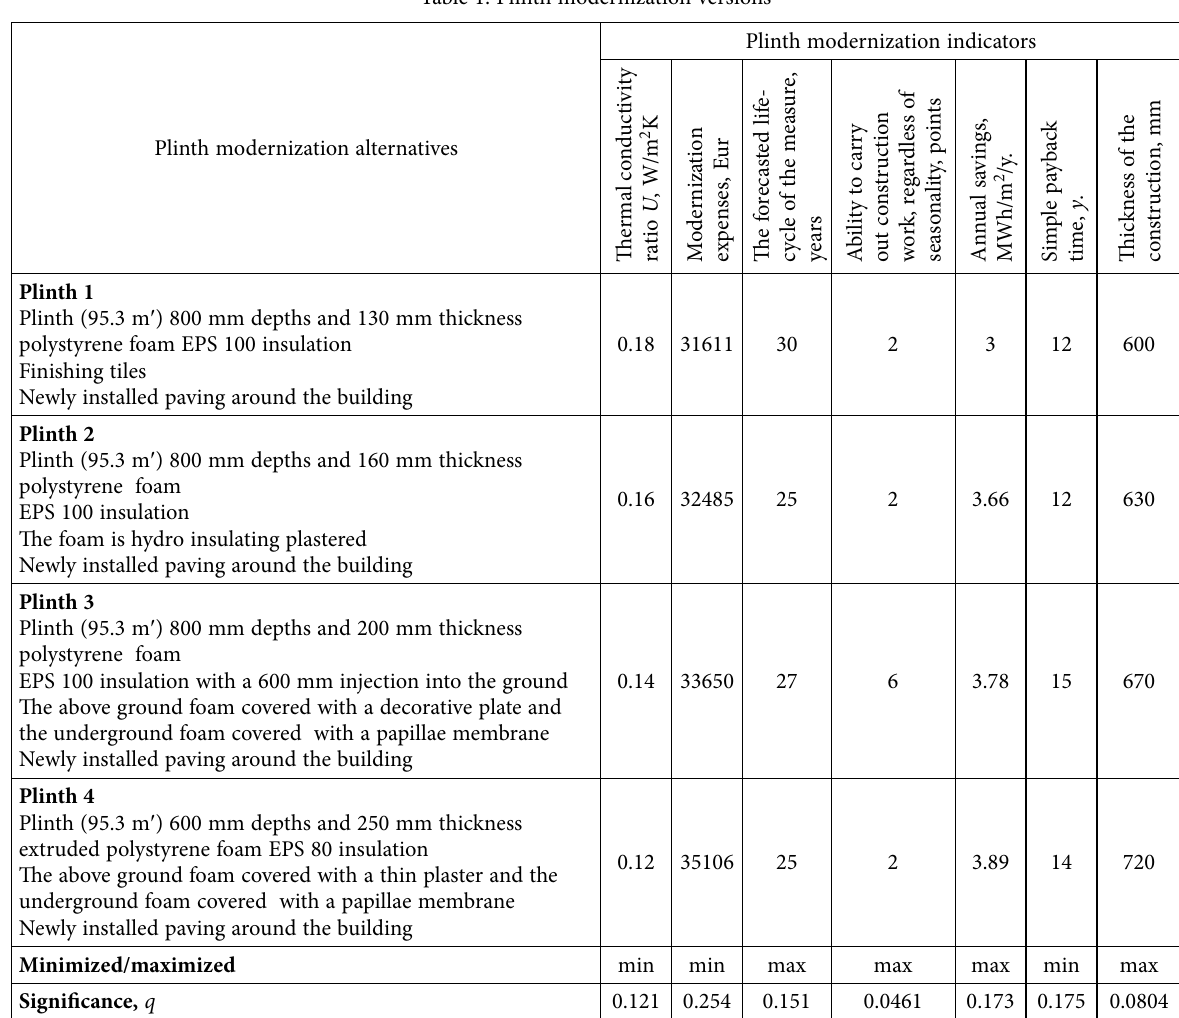
Table 1. Plinth modernization